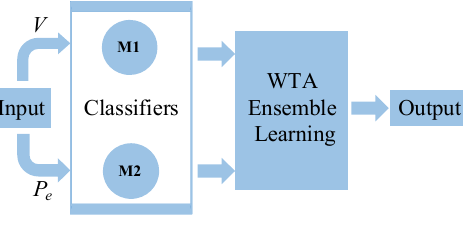
Figure 8. WTA ensemble learning model.